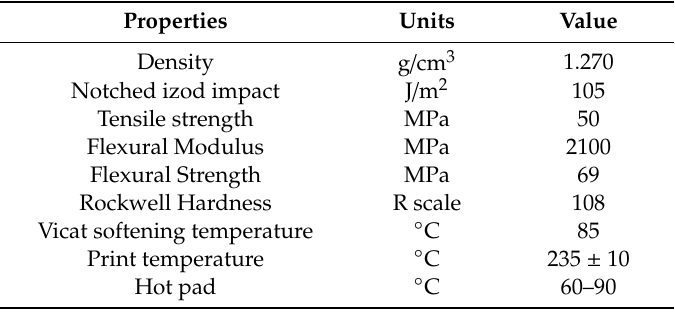
Table 2. Mechanical, physical properties and printing FDM features for PETG